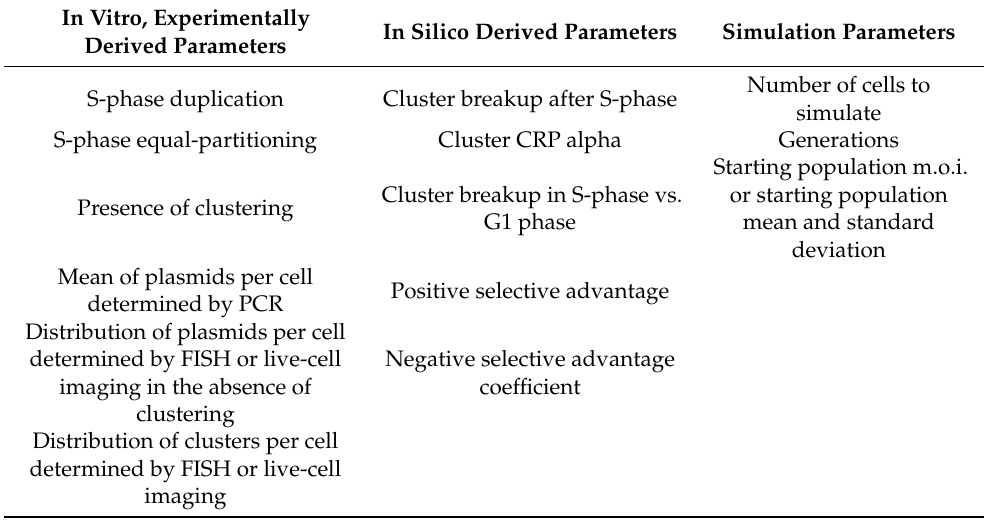
Table 1. Parameters used in